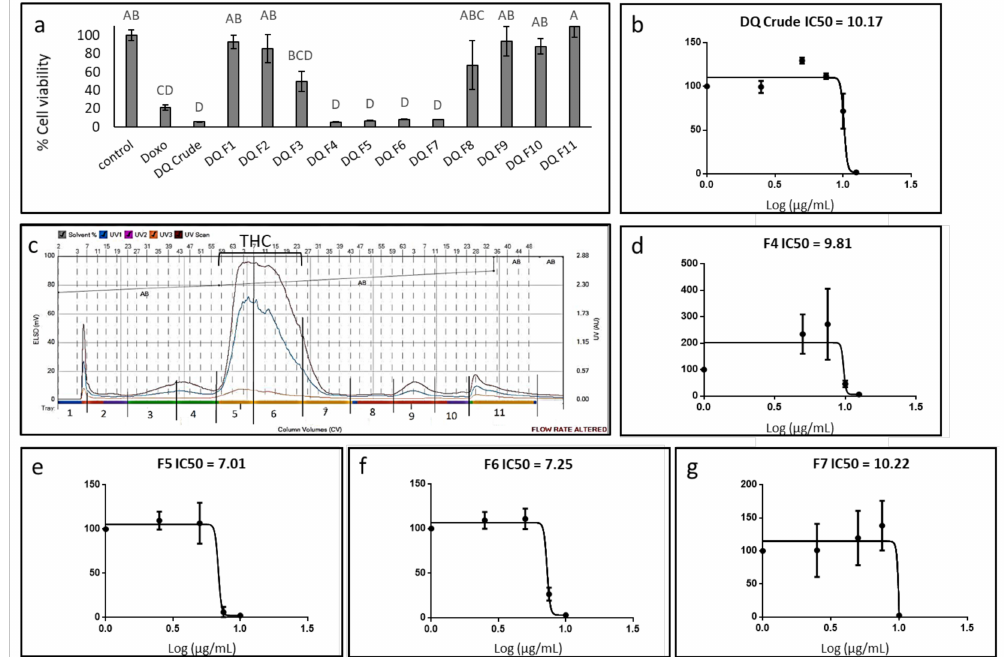
Figure 1. Cell viability of A172 cells following treatment with C. sativa Dairy Queen (DQ) crude extract and fractions. ( a ) Cell viability of A172 cells following treatment with crude extract and fractions F1-11 at a concentration of 12.5 µ g/mL for 48 h. Cell viability was determined by XTT assay as a function of live cell number. Doxorubicin (Doxo 0.5 µ g/mL) served as a positive control; control is the vehicle control (0.75% v / v methanol). Error bars indicate ± SE ( n = 3). Levels with different letters are significantly different from all combinations of pairs according to Tukey–Kramer honest significant difference (HSD; p ≤ 0.05). ( b ) Cell viability of A172 cells following treatment with C. sativa DQ crude extract at different concentrations. The IC50 values were calculated from 5P logistic curve fit using GraphPad Prism version 6.1. ( c ) Flash chromatography profile of C. sativa DQ crude extract. Fractions were collected and designated as F1–F11. The approximate range of the THC peak is shown. ( d – g ) Cell viability of A172 cells following treatment with C. sativa DQ fractions F4, 5, 6, 7 at different concentrations. The IC50 values were calculated from 5P logistic curve fit using GraphPad Prism version 6.1. Error bars indicate ± SE ( n =